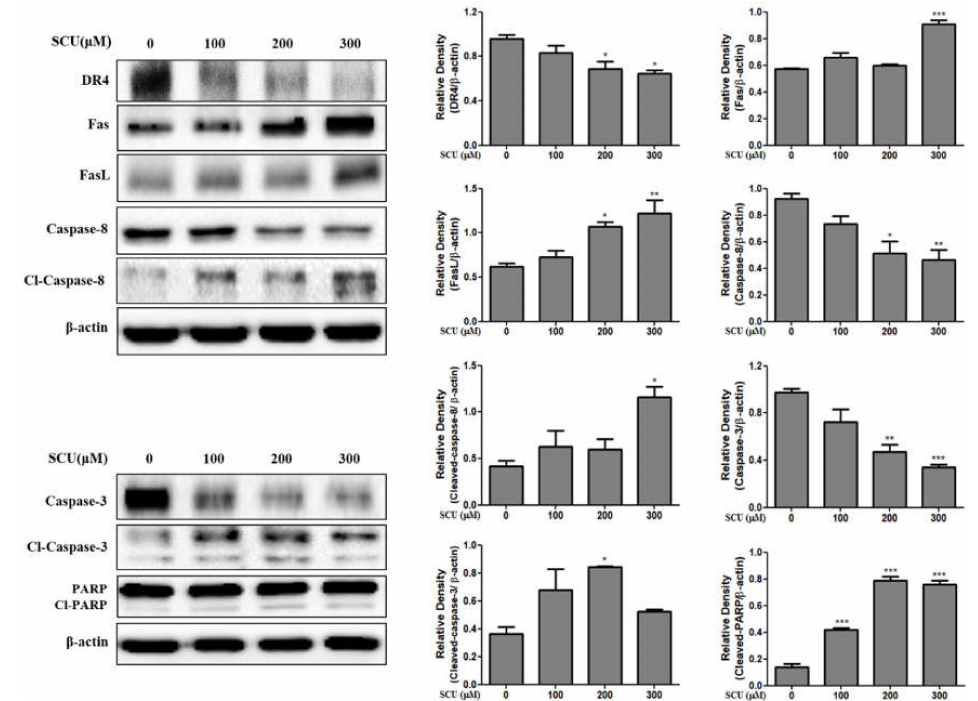
Figure 6. Scutellarein (SCU) induces Fas, FasL, caspase-8, and caspase-3 dependent apoptosis in Hep3B cells. The cells were treated with SCU at indicated concentrations (0-, 100-, 200-, and 300- µ M) for 24 h. Total cell lysates were resolved in sodium dodecyl sulfate (SDS)-polyacrylamide gels and transferred onto polyvinylidene difluoride (PVDF) membranes. The membranes were probed with death receptor 4 (DR4), Fas, Fas ligand (FasL), cleaved caspase-8, cleaved caspase-3, cleaved- polymeric adenosine diphosphate ribose (PARP), and β -actin antibodies. The proteins were visualized using electrochemiluminescence (ECL) detection system. Values are given as the mean ± standard error of the mean (SEM). * p < 0.05 vs. Hep3B cell control, ** p < 0.01 vs. Hep3B cell control, *** p < 0.001 vs. Hep3B cell